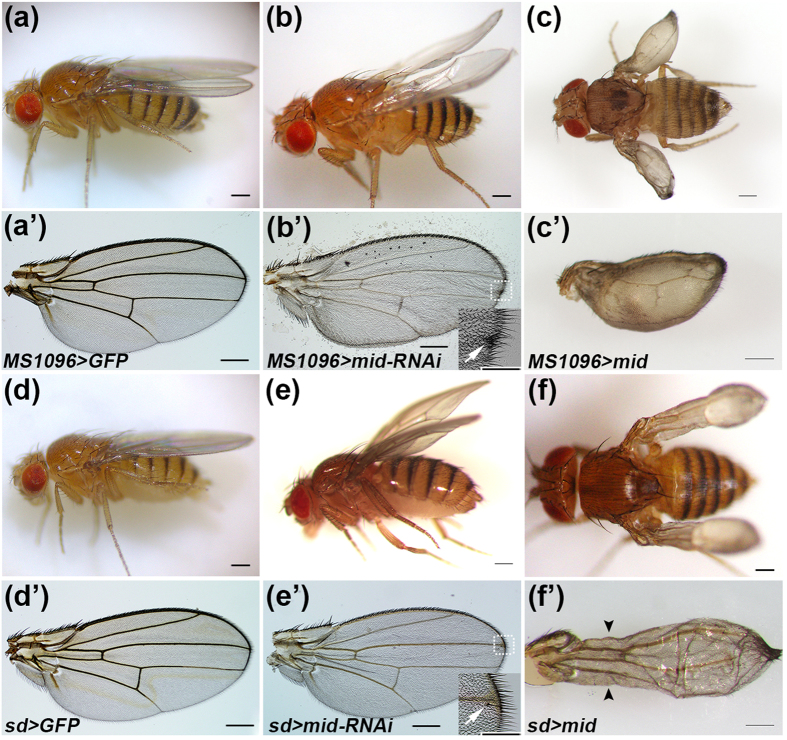
Mid is required for wing development.(a,a’) Adult wings of MS1096-Gal4; UAS-GFP are shown as control. (b–c’) Adult wings of MS1096-Gal4;UAS-mid-RNAi (b,b’) and MS1096-Gal4;UAS-mid (c,c’).(d,d’) Adult wings of sd-Gal4;UAS-GFP are shown as control. (e–f’) Adult wings of sd-Gal4;UAS-mid-RNAi (e,e’) and sd-Gal4;UAS-mid (f,f’). Insert of (b’) or (e’) represents magnification of the region marked by a white broken line. Arrows indicate ectopic wing hairs. Arrowheads indicate loss of tissue at the margin of wing blade. Scale bars: 500 μm.